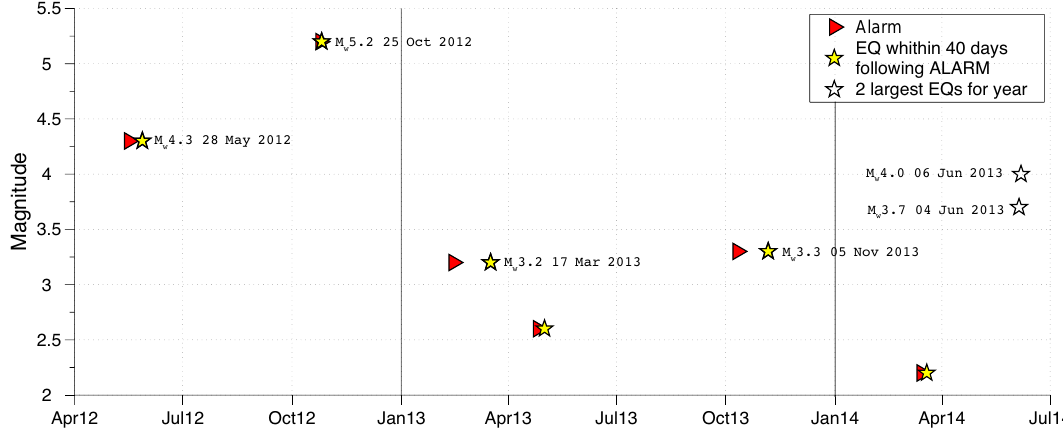
Figure 11. Output of the detection algorithm applied to time series of radon concentration at MMN. The red triangles represent all the issued alarms, yellow stars represent the greatest seismic events occurred in the 40 days following each alarm. For each year the two greatest seismic events have been also displayed (white stars), with corresponding occurrence date and magnitude.